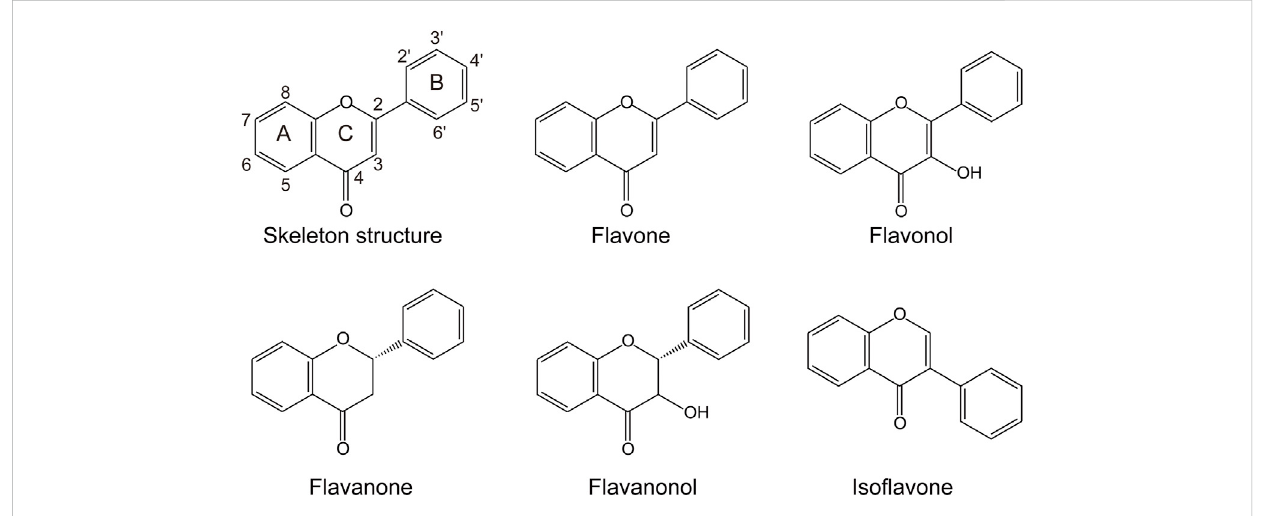
The skeleton structure of the main classes of fl